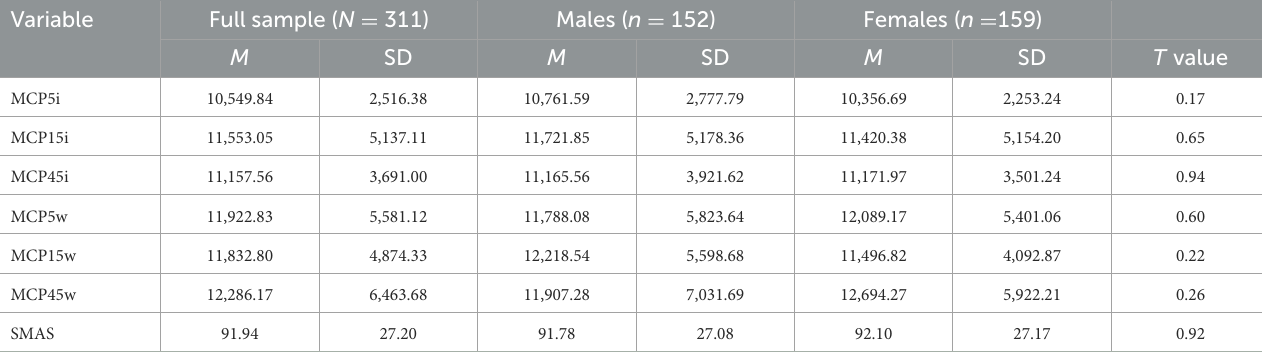
TABLE 1 Means and standard deviations for the main study variables. Variable